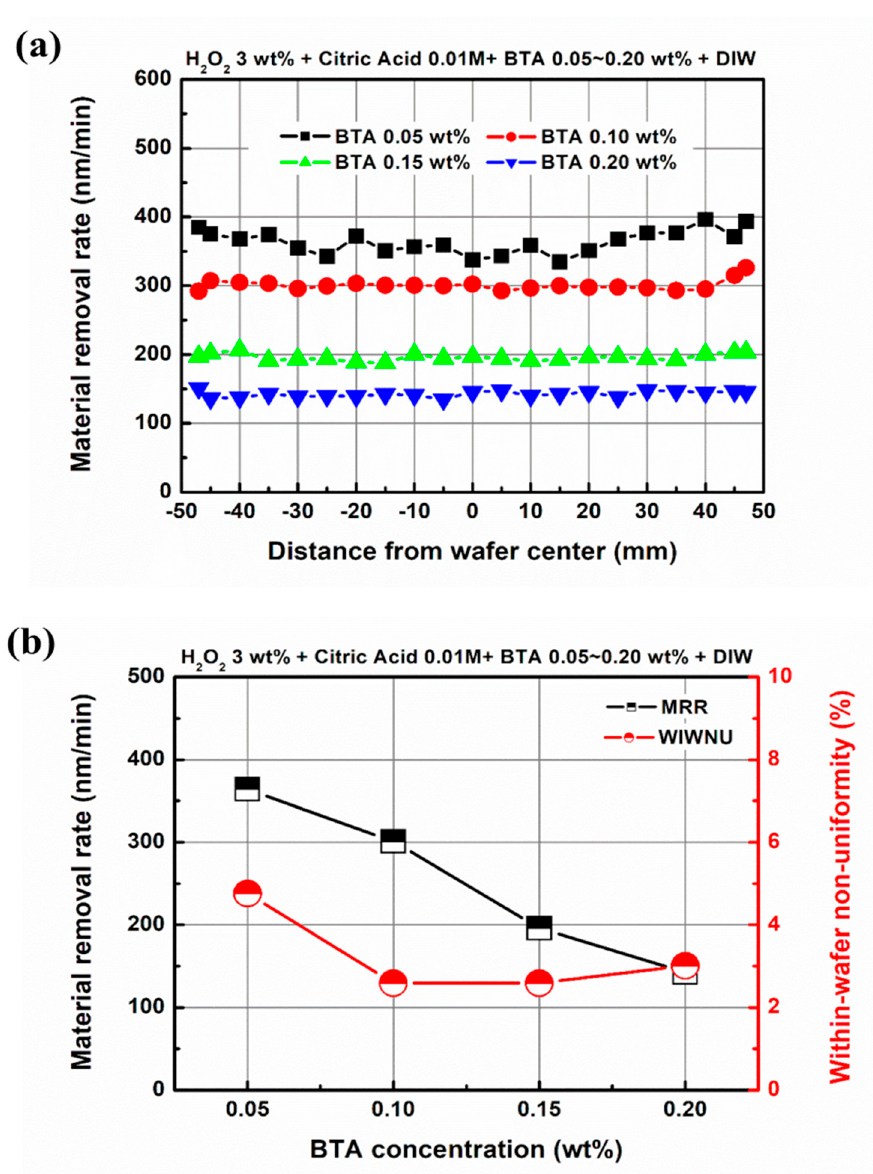
Figure 12. CMP results as a function of BTA concentration; ( a ) MRR distribution and ( b ) average MRR and WIWNU.